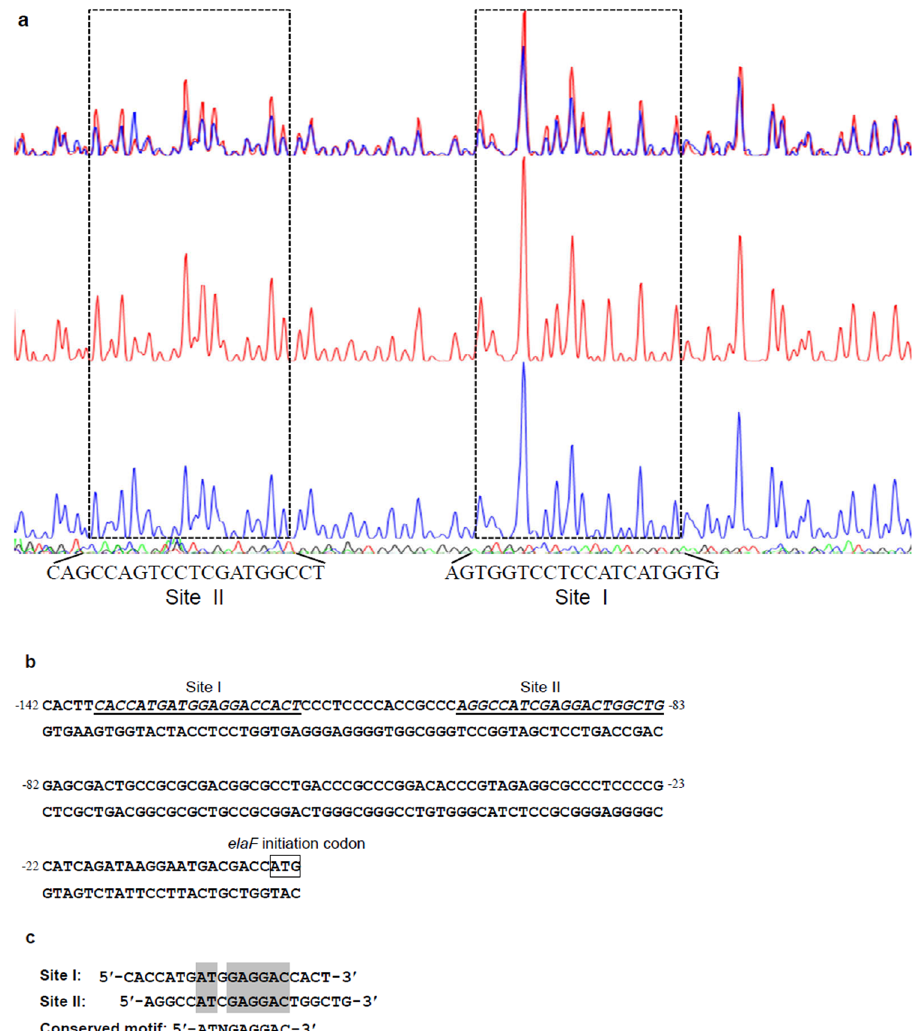
Figure 6. Determination of the binding sites of of GdmRIII. ( a ) DNase I footprinting assay of the elaF promoter protected by GdmRIII. The middle electropherogram represents the sequencing reaction without GdmRIII protein and the lower electropherogram represents the reaction with GdmRIII protein added. The regions where the blue peaks are constantly lower than the red peaks are considered to be protected by GdmRIII; ( b ) the nucleotide sequence of the elaF promoter region and the GdmRIII binding sites. The numbers indicate the distance (nt) from the translational start point. The solid lines indicate the GdmRIII binding sites. ( c ) the conserved sequence among GdmRIII binding